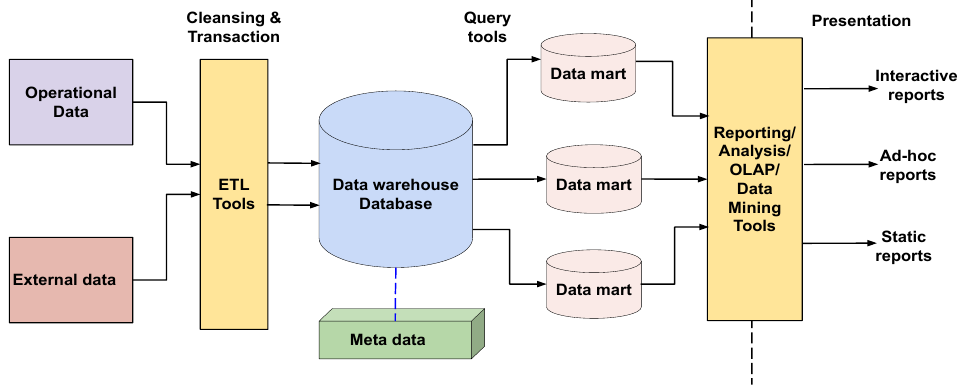
Figure 2. Data warehouse